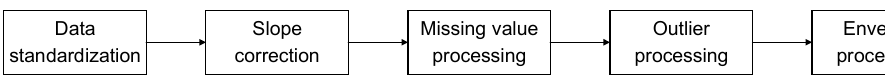
Figure 1. Pre-processing of texture data.